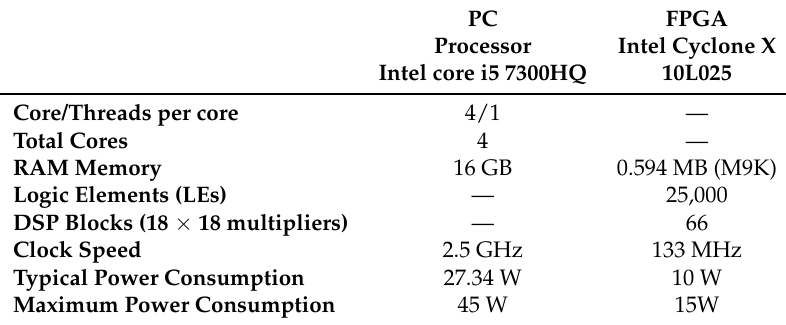
Table 1. PC and FPGA